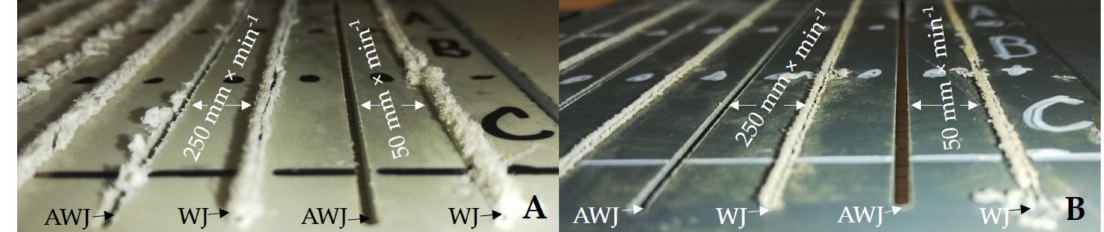
Figure 15. Detailed view on the outlet side of the water jet from machined materials: ( A ) PP + MOBIHEL; ( B ): PVC- U + POLURAN.